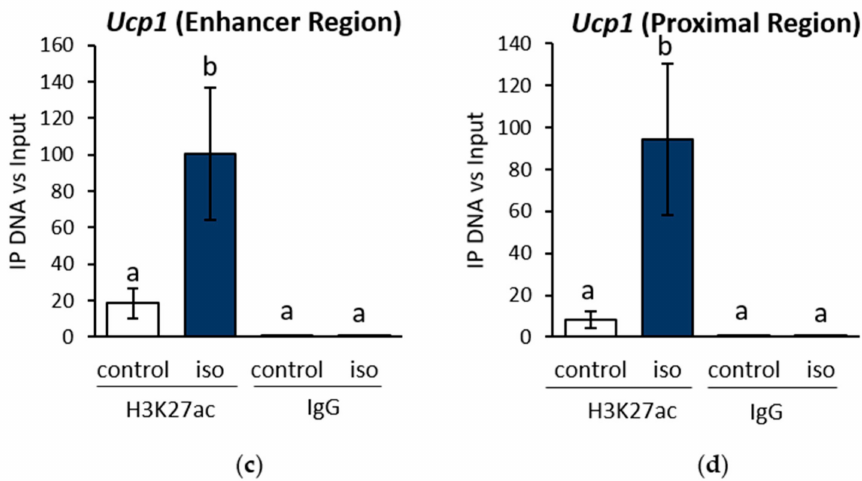
Figure 2. Histone acetylation state under β -adrenergic receptor ( β -AR) stimulation in IWAT cell. ( a ) Ucp1 expression after induction by 10 µ M β -AR agonist isoproterenol (iso) over time, and H3K27ac level in ( b ) whole cells, ( c ) Ucp1 enhancer region, and ( d ) Ucp1 proximal region after induction by 10 µ M β -AR agonist isoproterenol (iso) for 4 h. IgG act as a mock control. Data are presented as mean ± S.E.M. (error bars). n = 4–6 in each group. Different letters indicate significant difference ( p < 0.05) according to one-way ANOVA followed by the Tukey-Kramer multiple comparison test. Same letters indicate non-significant